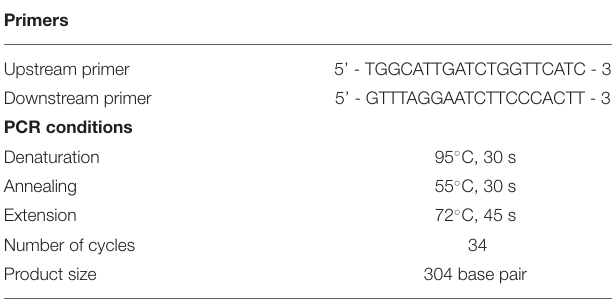
TABLE 1 | Primers and PCR